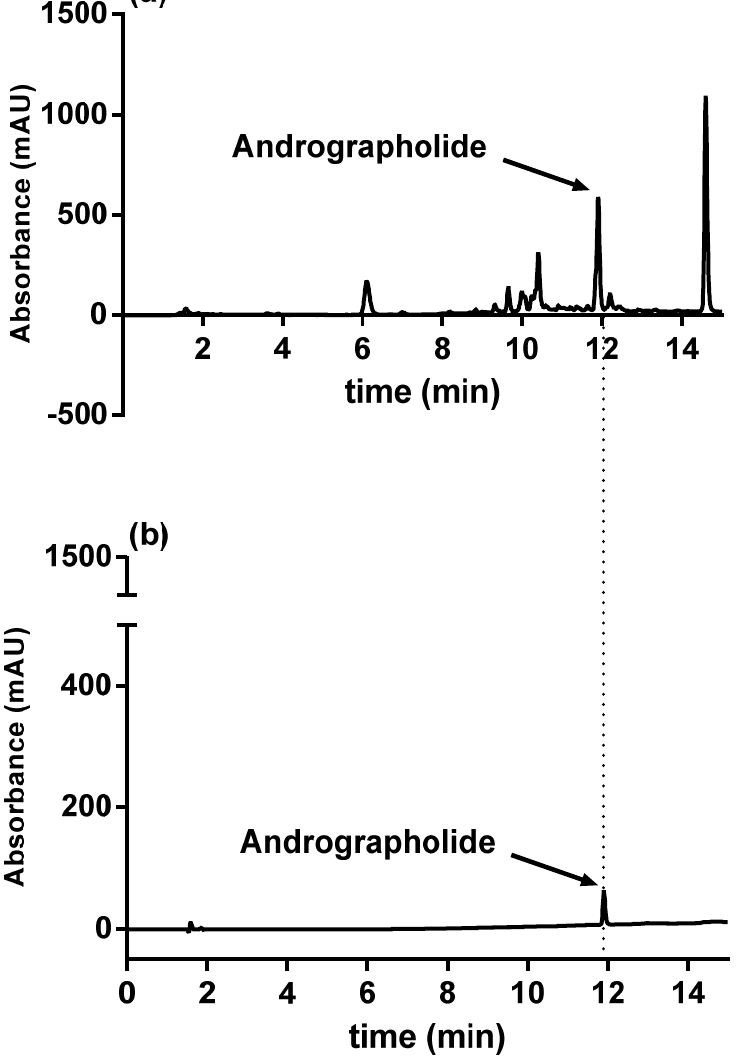
Figure 1. HPLC results of ANDRO from ME of Andrographis paniculata ( a ); ANDRO standard ( b ). Abbreviations: ANDRO, andrographolide; ME, methanolic extract.